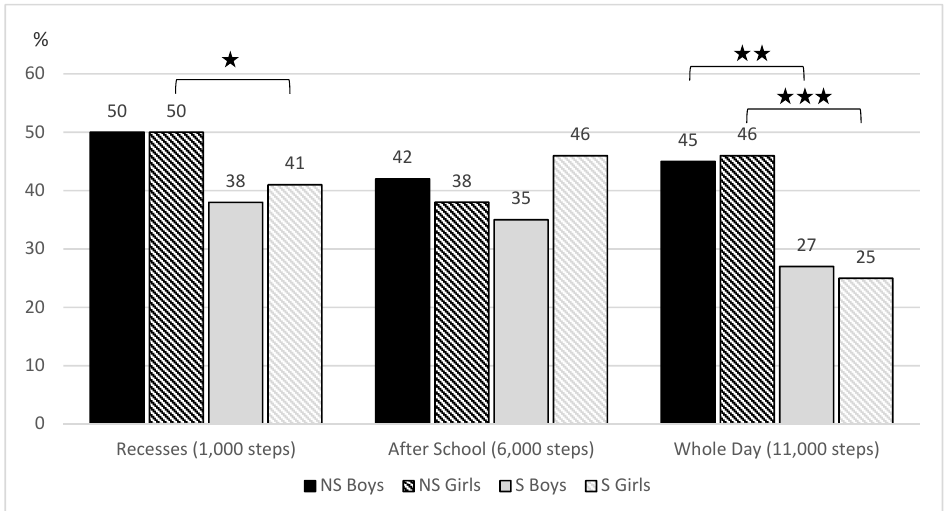
Figure 1. Meeting the guidelines for step count in different day segments (1000 steps/day during